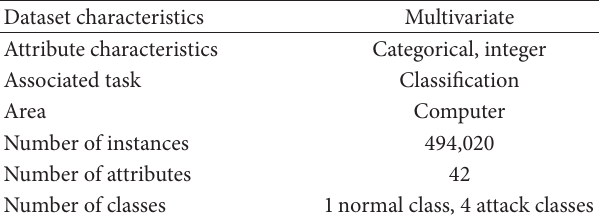
Table 3: Feature information of 10% KDDCUP